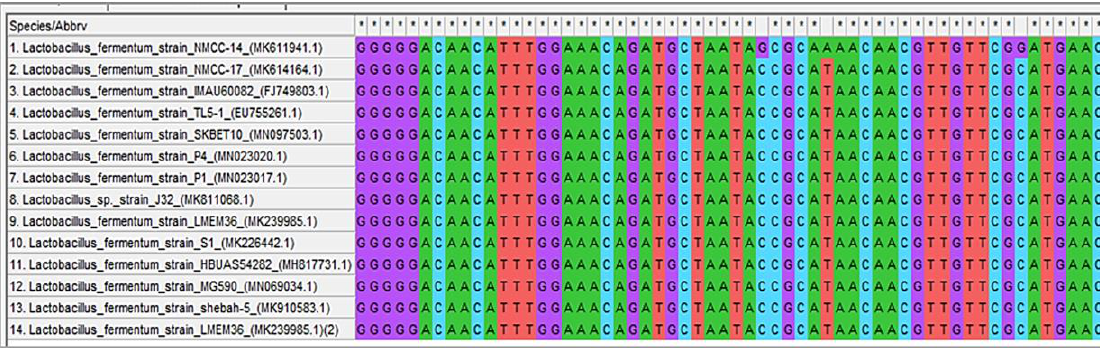
Figure 10. Multiple sequence alignment of Lactobacillus fermentum NMCC-14 bacterial strain.